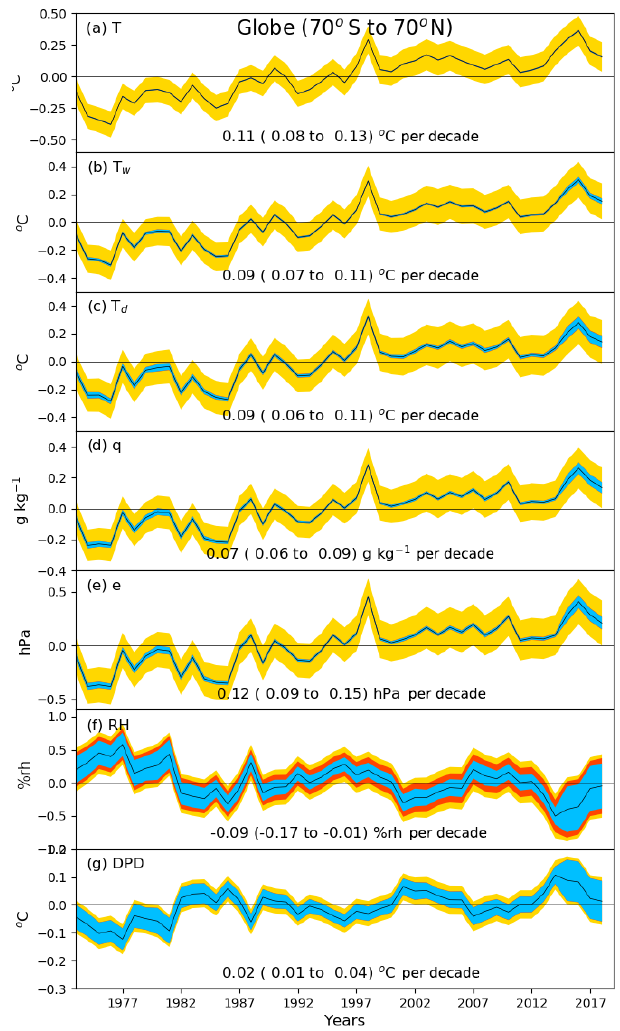
Figure 12. Global-average time series of annual mean climate anomalies for all variables. The 2 σ uncertainty ranges for total ob- servation (blue), sampling (red) and coverage (gold) uncertainty contributions combined are shown. All series have been given a zero mean over the common 1981–2010 period. Decadal linear trends and 90th-percentile confidence intervals (in parentheses) were fit- ted using ordinary least-squares regression with AR(1) correction applied when calculating the confidence intervals (Santer et al., 2008), with the range representing the 90% confidence interval in the